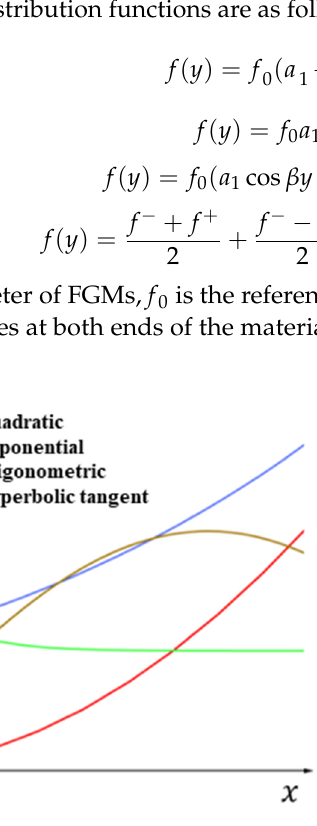
Figure 5. FGM material distribution characteristics and parameter changes.